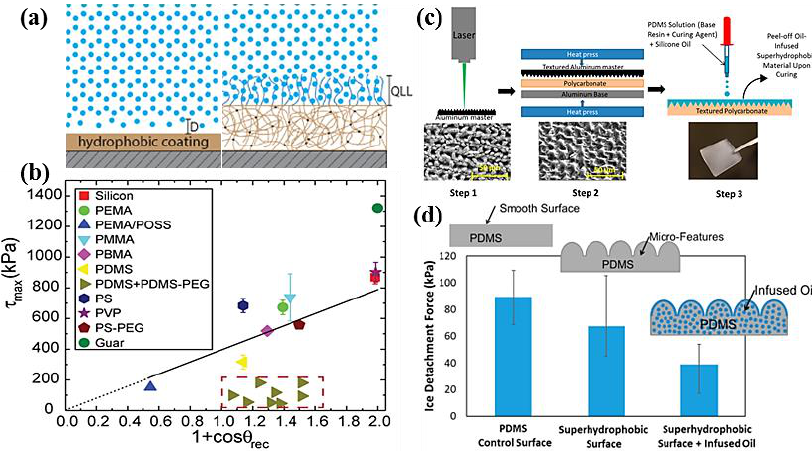
Figure 18. ( a ) Proposed mechanisms responsible for low ice adhesion on two distinct types of